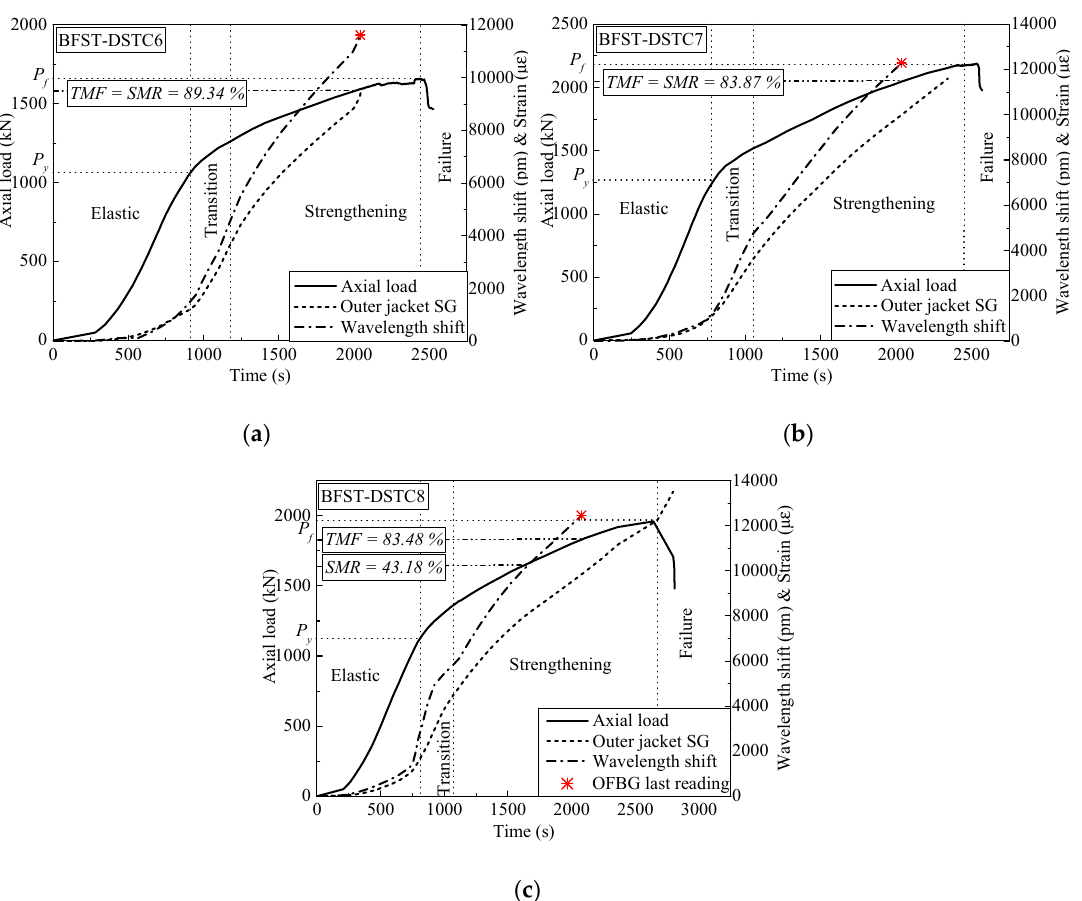
Figure 7. Hoop strain self-sensing performance of the outer tube for specimens with high-strength concrete (HSC): ( a ) BFST-DSTC6; ( b ) BFST-DSTC7; ( c ) BFST-DSTC8. TMF: Total measurement from OFBGs, SMR: Strain measurement range, * OFBGs last reading.